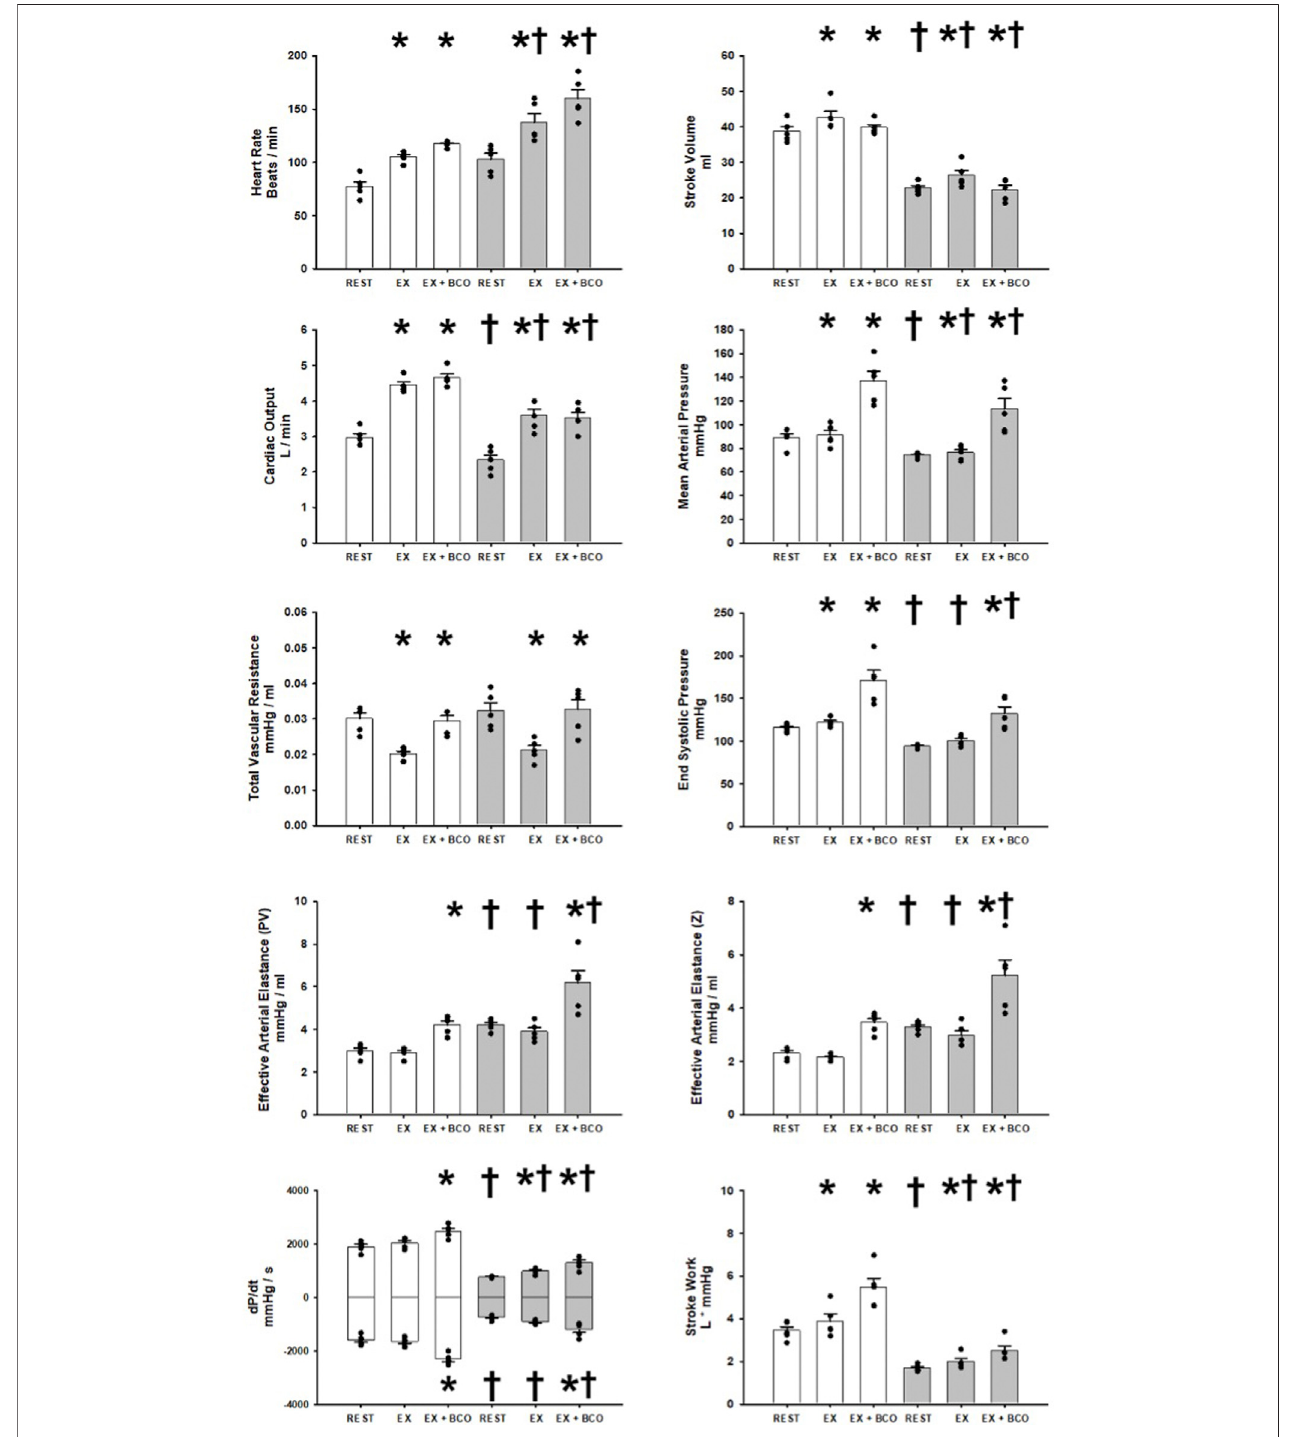
FIGURE 3 | One-minute averaged hemodynamics at rest, exercise, and exercise with baroreceptor unloading via bilateral carotid occlusion (BCO), before (white bars)andafterinductionofheartfailure(greybars).Dataarereportedasmeanswitherrorbarsdepictingthestandarderrorofthemean.Actualobserveddatapointsare overlain on corresponding bar graphs. Statistical signi fi cance against the previous exercise workload depicted as * p < 0.05 and signi fi cant against previous state at the same workload depicted as † where p < 0.05. ( N = 5).